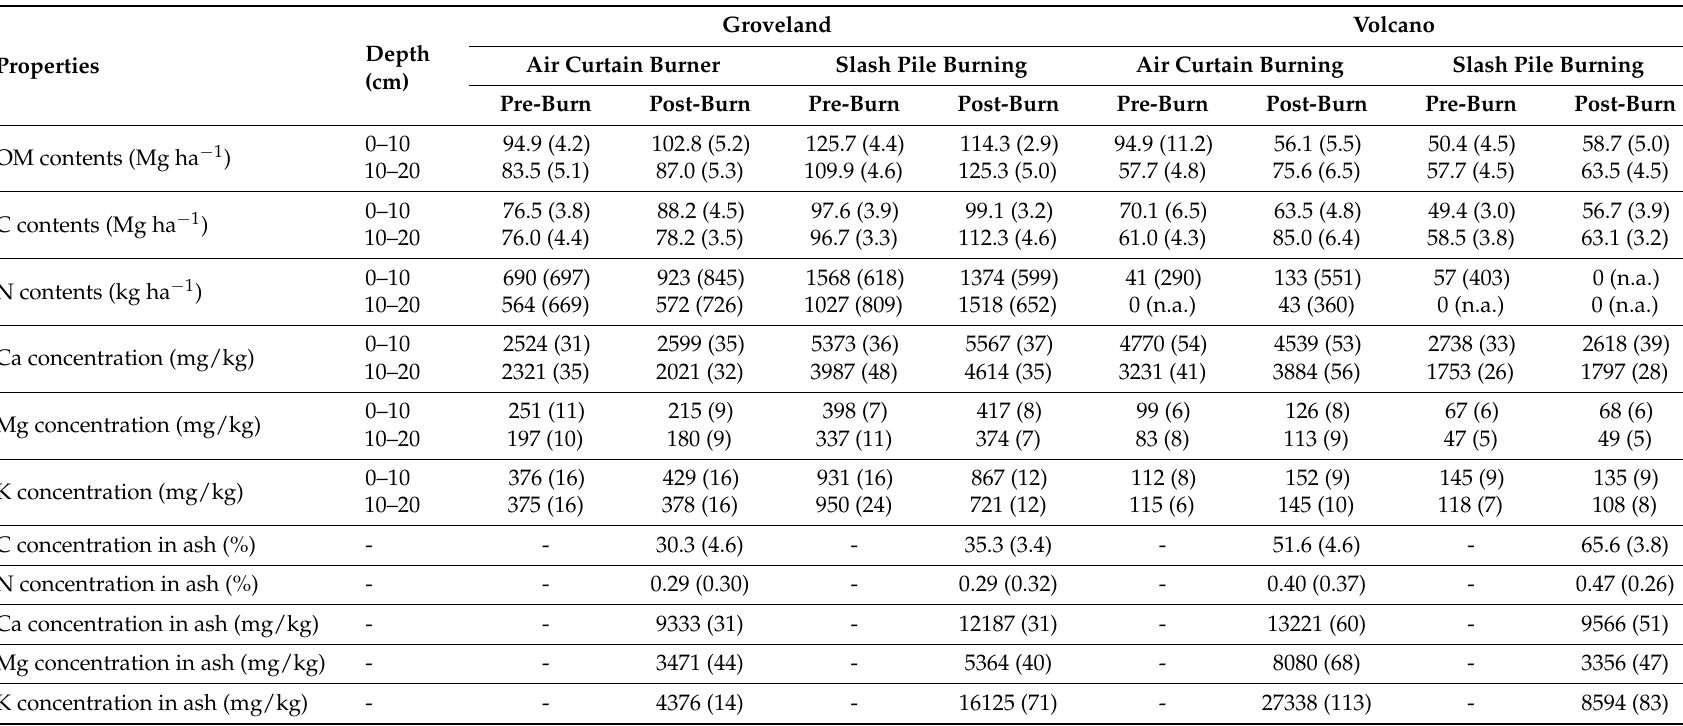
Table 3. Average change from pre-burn to post burn in soil chemical properties at two soil depths in the mineral soil and C and N concentration of ash samples. Values in parentheses are the standard error (n = 18 for each burning